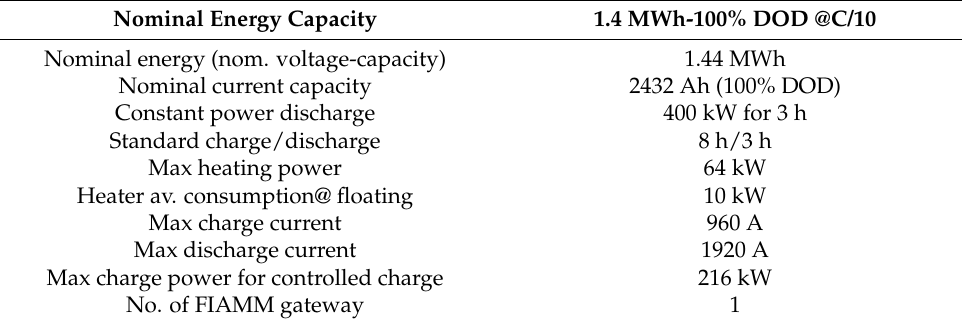
Figure 17. Photo of the Tilos HPS BESS, installed at the northwestern part of the island. Table 3. Main characteristics of installed BESS.